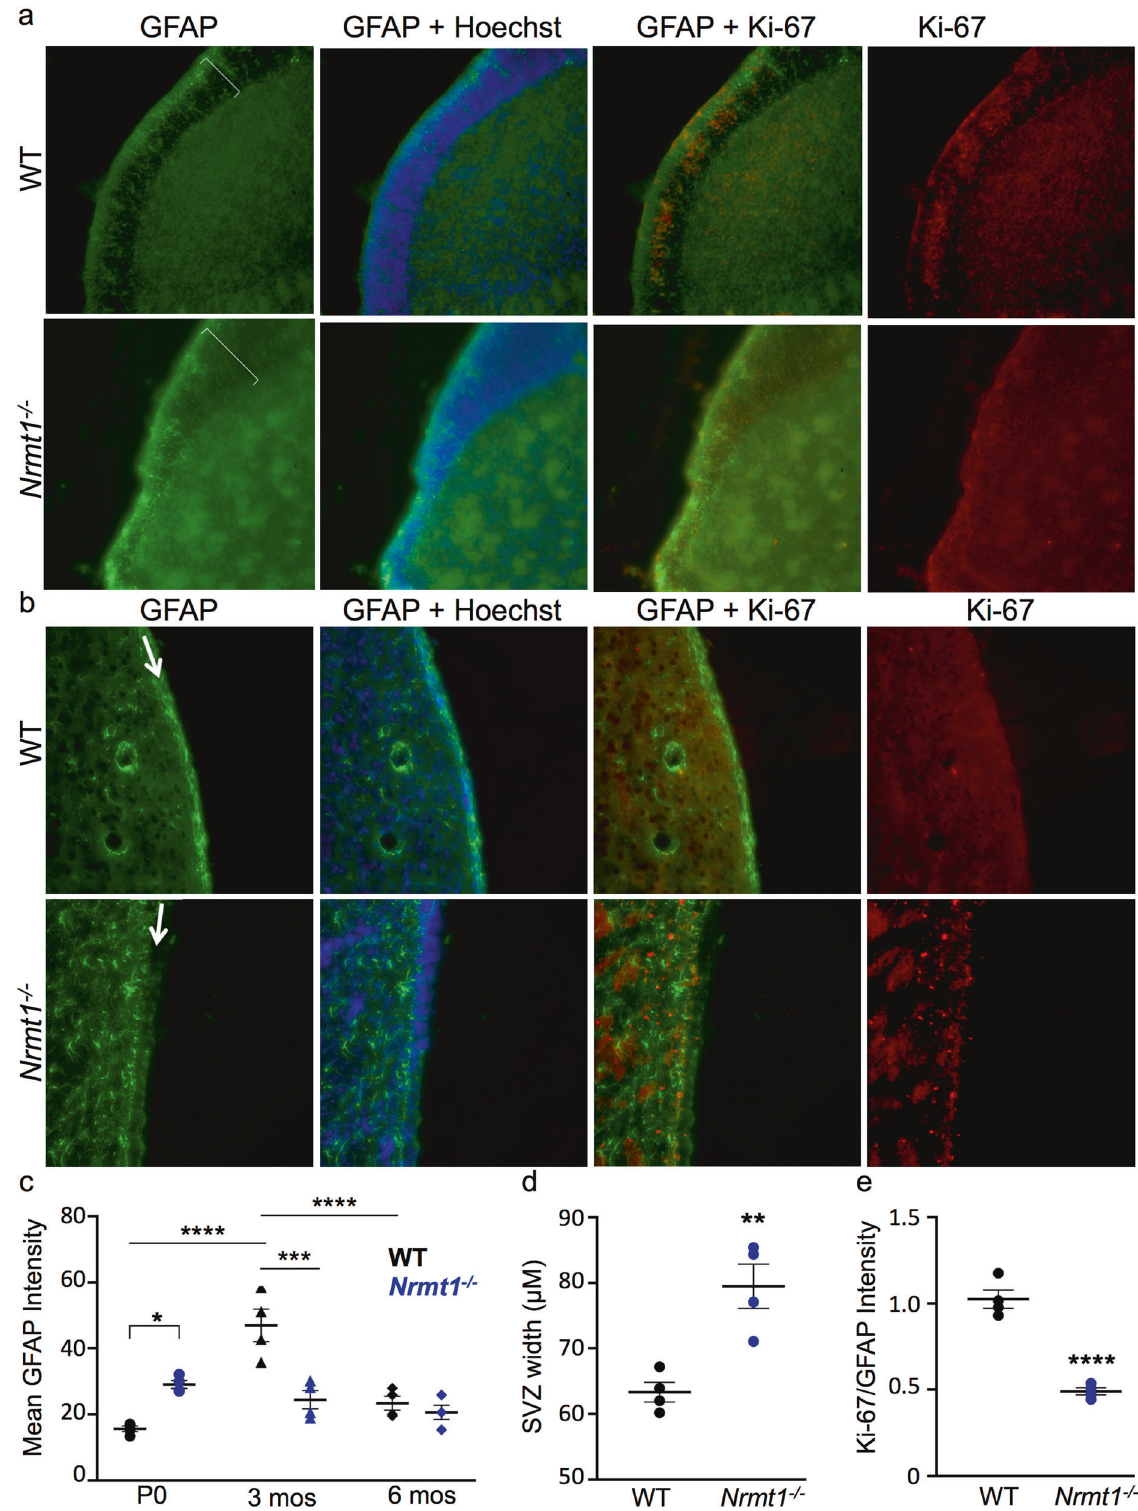
Fig. 5 An early expansion of the RGL pool in the SVZ of Nrmt1 − / − mice is followed by premature depletion. a , c At P0, there is a signi fi cant increase in GFAP staining in the SVZ (brackets) of Nrmt1 − / − mice. b , c At 3 months, GFAP staining is signi fi cantly decreased in the SVZ (arrows) of Nrmt1 − / − mice, indicating the early expanded GFAP + pool has become depleted. d , e Although the width of the SVZ and intensity of GFAP staining are signi fi cantly higher in Nrmt1 − / − mice at P0, the ratio of Ki-67/GFAP is lower than WT, indicating the GFAP + cells are not undergoing higher rates of proliferation in Nrmt1 − / − mice. ** p < 0.005, *** p < 0.0005, and **** p < 0.0001 as determined by unpaired t -test, n = 3 – 4. Error bars represent mean ± SEM. Scale bar = 1000 μ m.